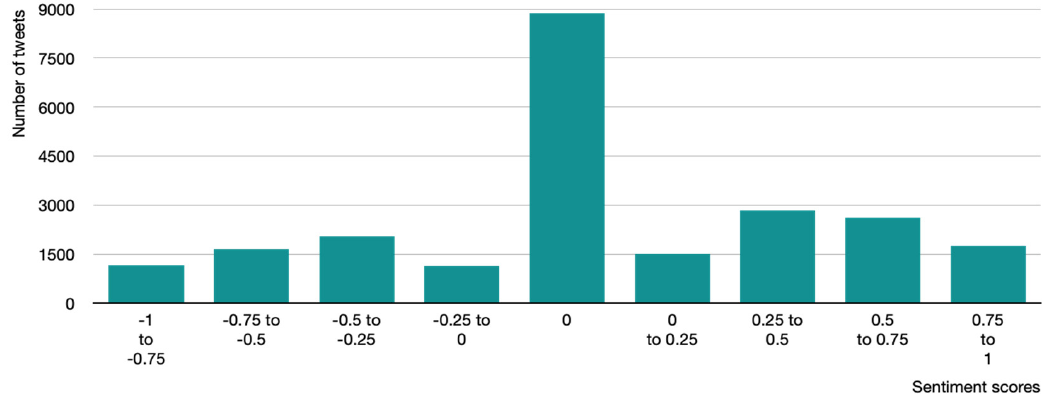
Figure 4. Distribution of tweets in the intervals for specific sentiment scores.